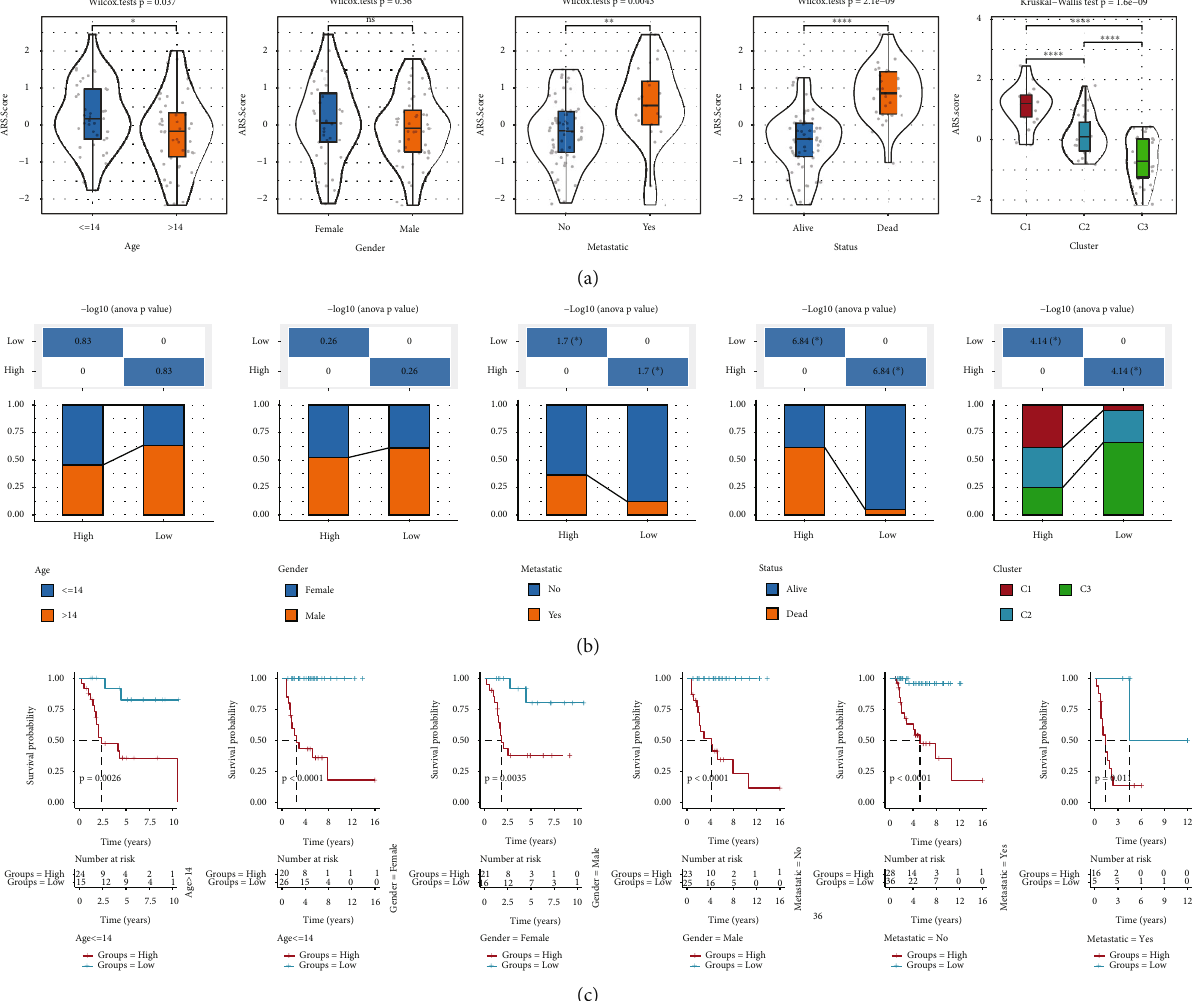
Figure 6: The correlations between the risk score and clinicopathological characteristics of osteosarcoma in the TCGA cohort. (a) The distribution of risk score in di ff erent groups separated by age, gender, metastasis, and status. (b) Comparison of age, gender, metastasis, status, and molecular subtypes between the high- and low-risk groups. (c) Kaplan-Meier survival subgroup analysis of all patients with osteosarcoma according to the risk signature strati fi ed by clinical characteristics, including age, gender, and metastasis. The survival probabilities were compared with log-rank test. ns: no signi fi cance. ∗ P < 0 : 05, ∗∗ P < 0 : 01, ∗∗∗ P < 0 : 001,and ∗∗∗∗ P < 0 : 0001